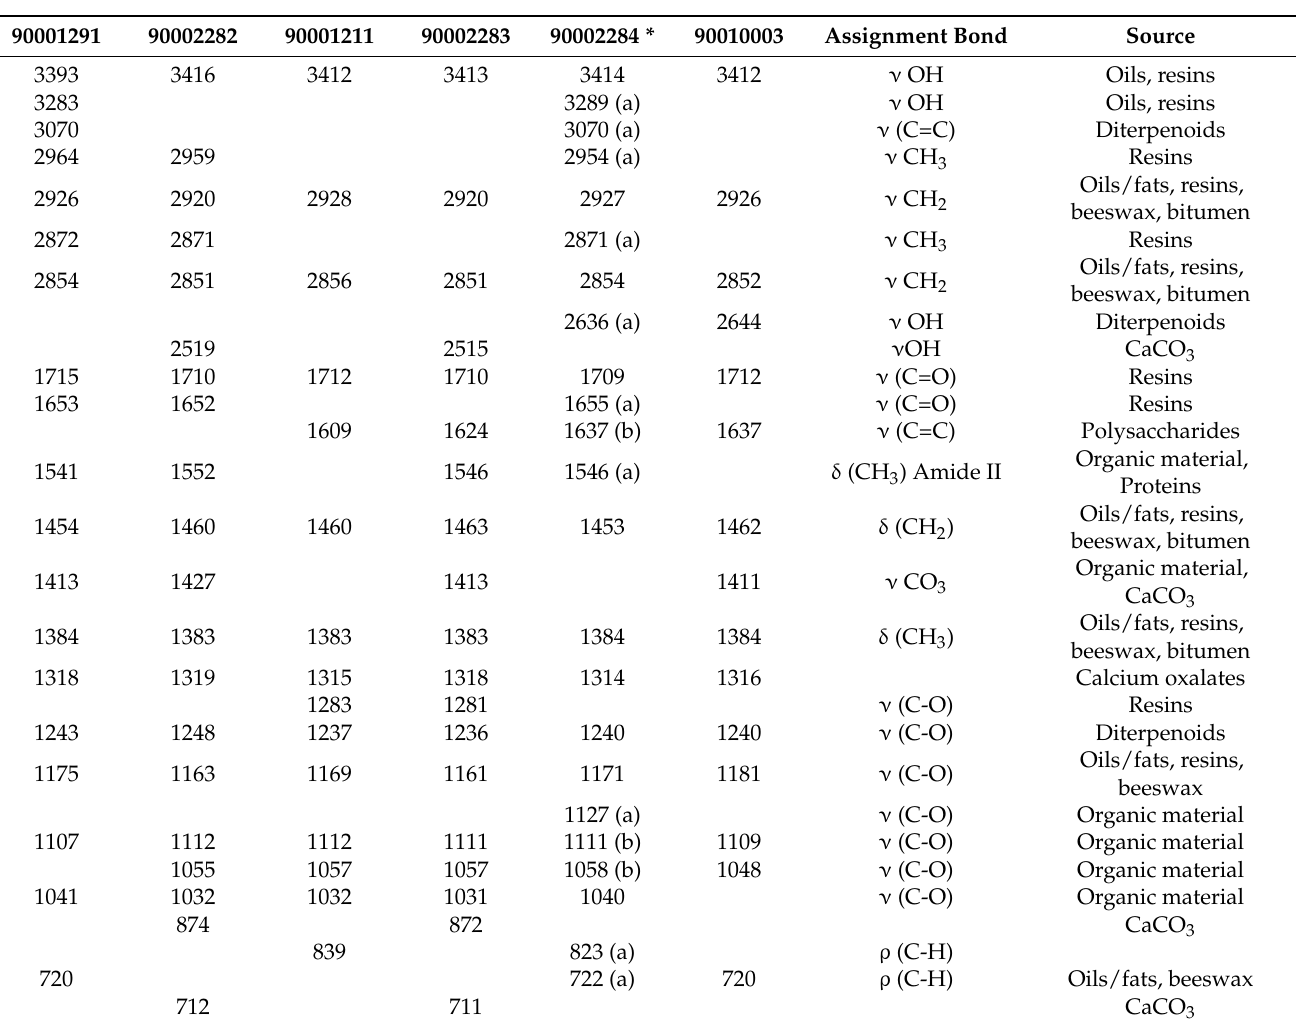
Table 1. FT-IR interpretation and initial data assessment ( ν —stretching vibration; δ —bending vibration; ρ —rocking